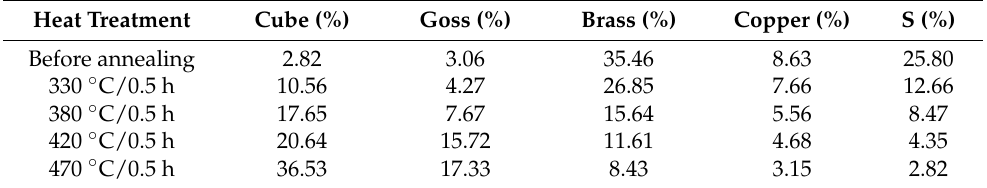
Figure 11. Sections ( ϕ = 0 ◦ ) of ODFs on the rolling plane of the cold-rolled sample after different annealing treatments: ( a ) before annealing; ( b ) 330 ◦ C/0.5 h; ( c ) 380 ◦ C/0.5 h; ( d ) 420 ◦ C/0.5 h; ( e ) 470 ◦ C/0.5 h. Table 4. Volume fractions of different textures, calculated based on the ODF of 80% cold-rolled samples after different annealing treatments (with a measurement accuracy of 0.05%).